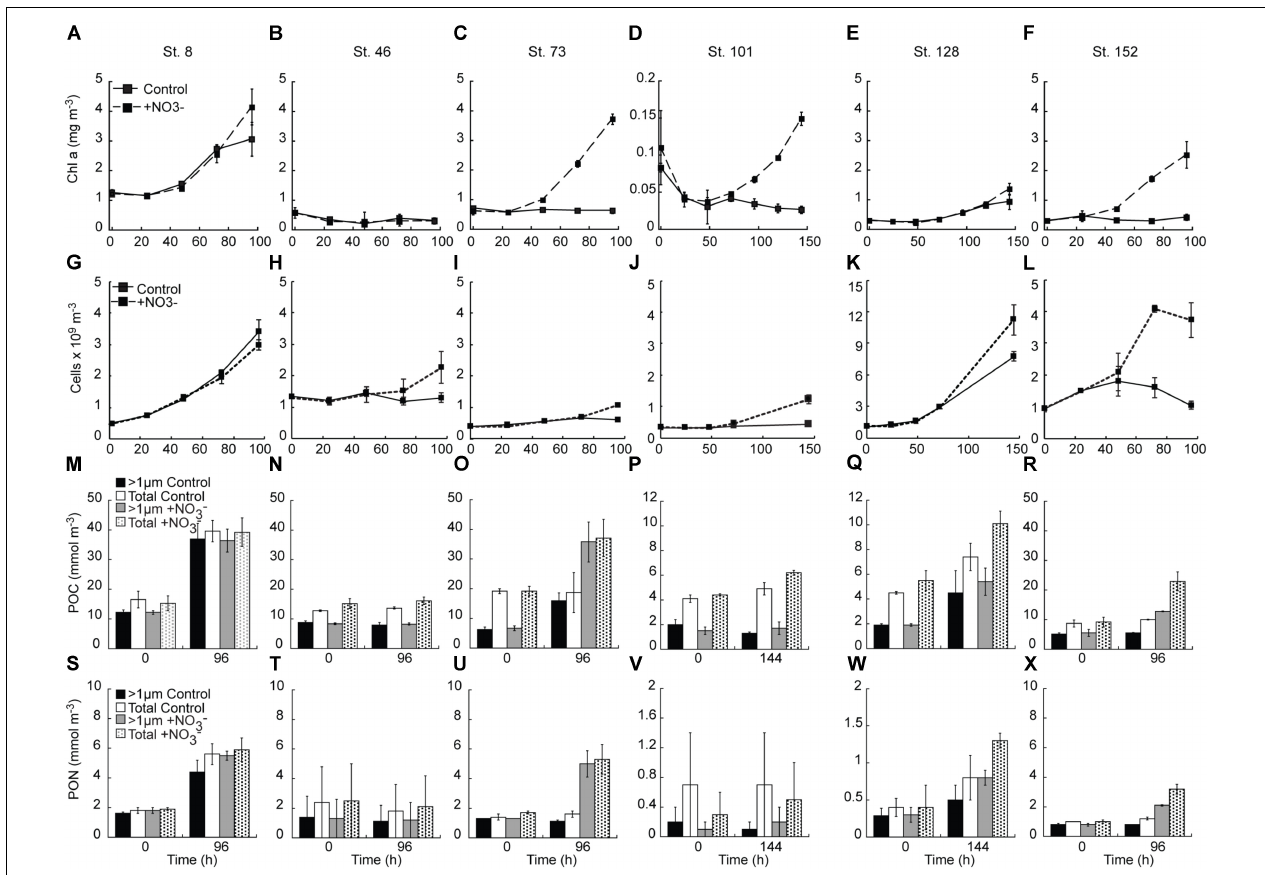
FIGURE 3 | Response of chlorophyll a (A–F) , phytoplankton ( < 10 µ m) cell concentration (G–L) , POC (M–R) and PON (S–X) concentrations to the addition of NO 3 − . Shown are average ( ± SD) concentration at each time point